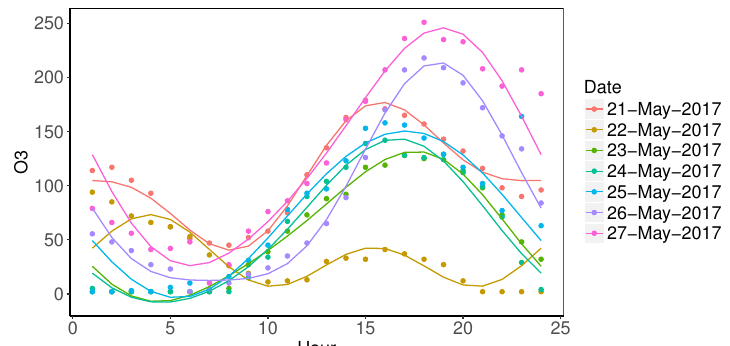
Figure 3. Ozone data fitting by using five Fourier basis